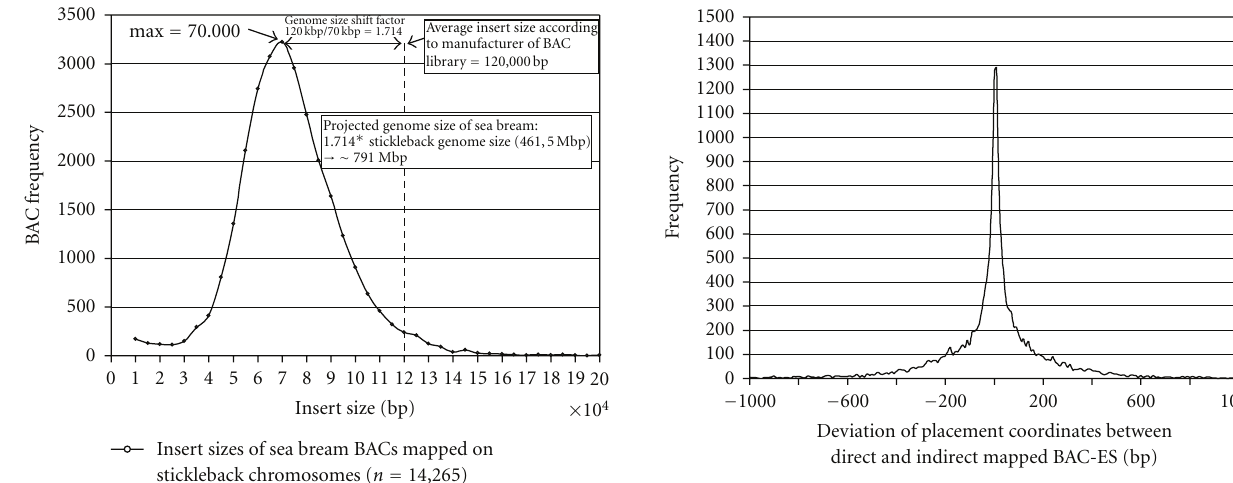
not as close in the phylogeny.